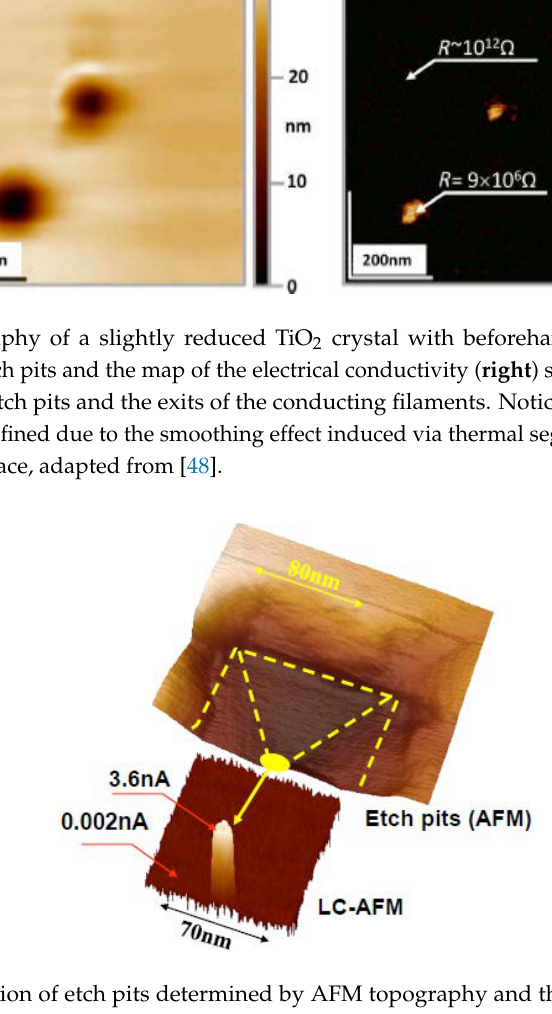
Figure 41. AFM ( a ) and LCAFM ( b ) investigations of the reduced and pre-etched SrTiO 3 bicrystal shows correlations between positions of the etch pits (along the boundary) and bands of the conducting filaments. This finding in fact confirms the hypothesis about easy reductions of the core of dislocations. Cross-section ( c ), obtained perpendicular to the boundary, presents that the broad conducting channels are accumulated along the boundary. The fold-up maps of the conductivity in-plane and out-of-plane indicate that a 3D network of filaments exists whose structure is a hierarchical network with high density of the extended defects very close to the surface and a declining concentration of defects in deeper parts of the surface region. A prominent example of such a hierarchical structure with locally enhanced conductivity is presented for a TiO 2 single crystal (see Figure 42) which was subjected to a thermal reduction strong enough to establish a pronounced, well-structured network of filaments (here, probably due to a chemical restructuring of the dislocation cores) [48]. We have found a similar density distribution of filaments in the surface region of reduced SrTiO 3 crystals (see Figure 43) with a high concentration of well- conducting filaments near the surface and a decline of the density towards the interior of the reduced